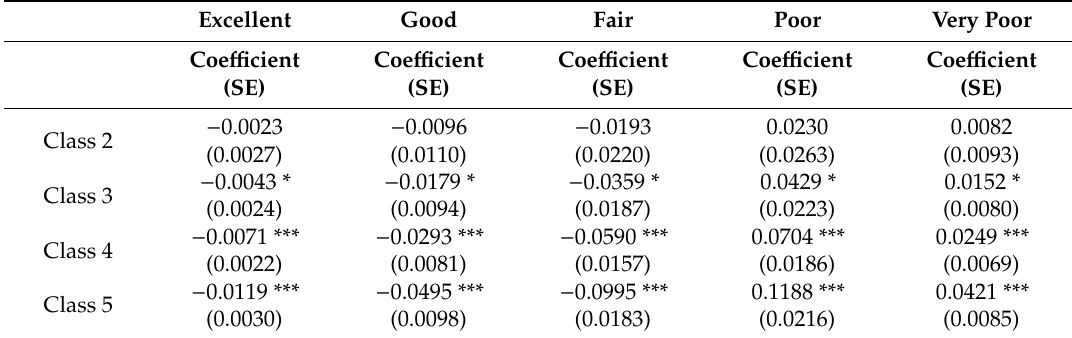
Table 7. Marginal e ff ect of latent class of health behavior by self-reported health status. Excellent Good Fair Poor Very Poor Coe ffi cient Coe ffi cient Coe ffi (SE)